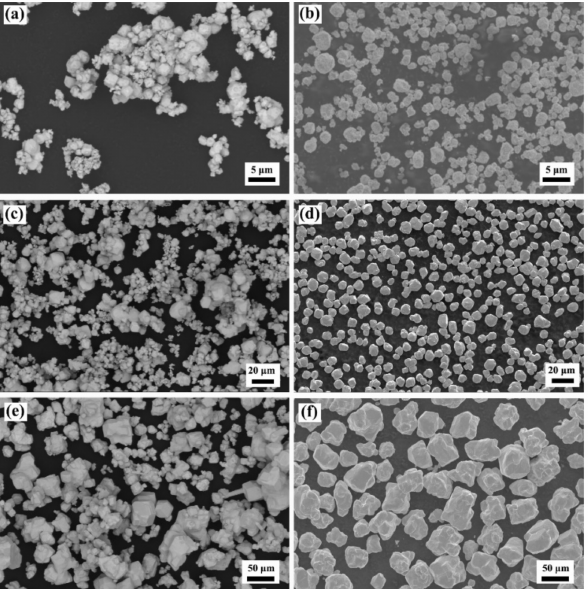
Figure 1. Morphology of commercial ( a ) 3, ( c ) 8, and ( e ) 20 µ m and jet-milled ( b ) 3, ( d ) 8, and ( f ) 20 µ m W powders.